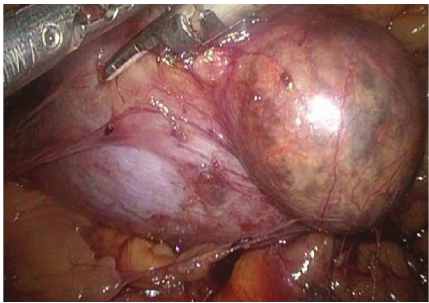
Figure 2: Retroperitoneal laparoscopic left partial